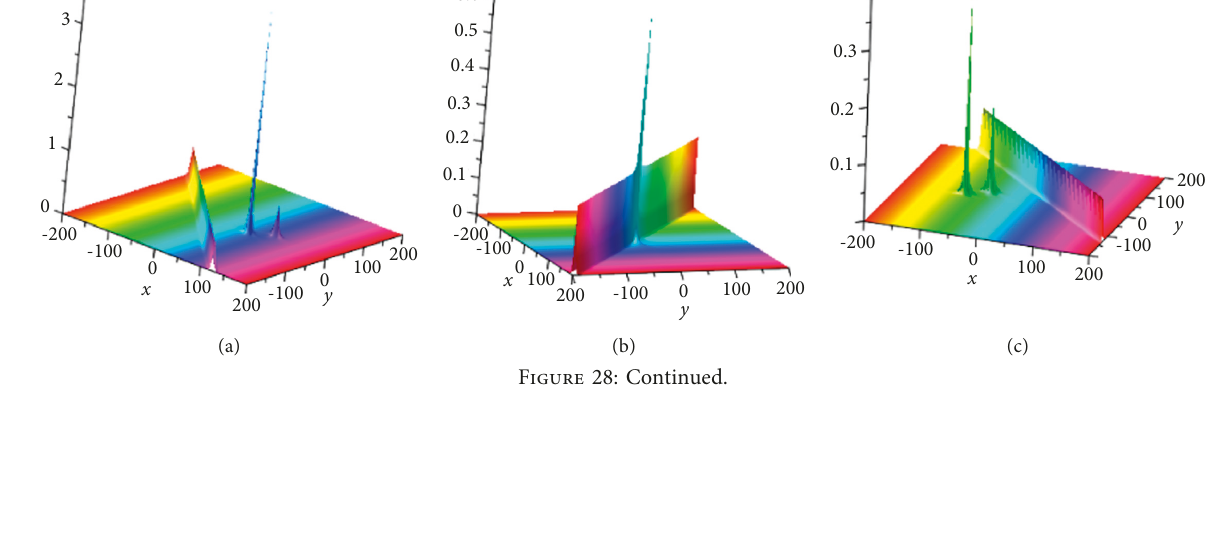
Figure 27: Plots of equation (89) by taking ϕ (c) f